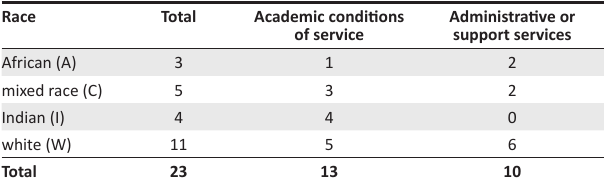
TABLE 2: Biographical data.